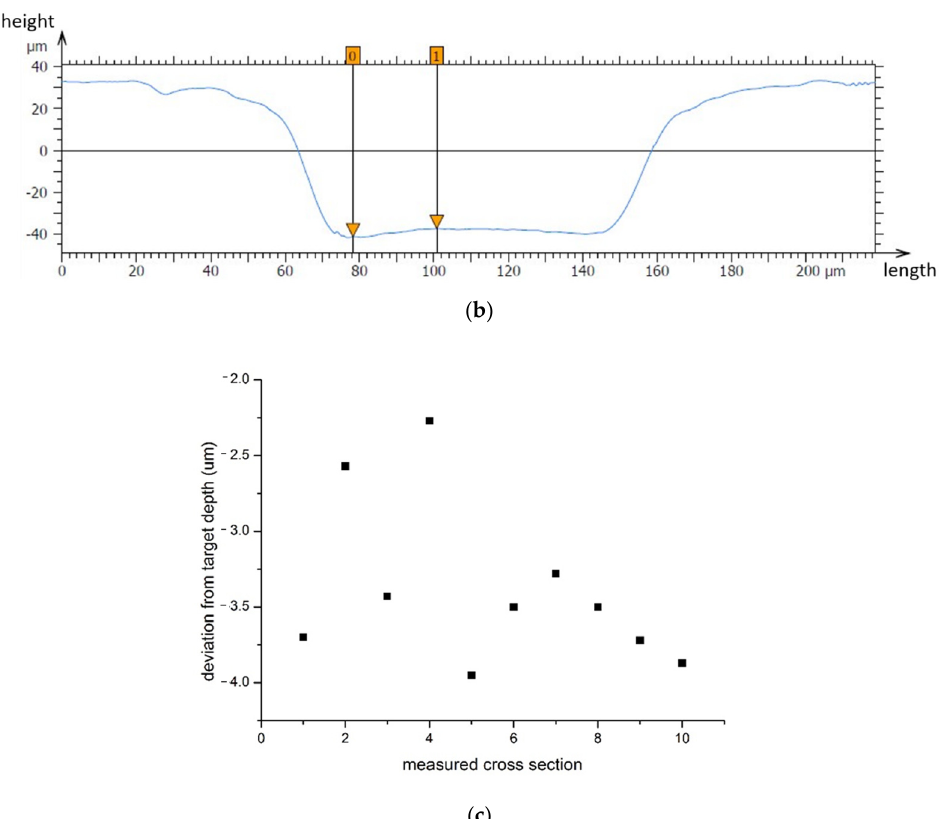
Figure 9. Ten different section positions were selected randomly for depth measurement: ( a ) measurement position of the microgroove cross section, ( b ) bottom morphology of the microgroove and the depth difference between the highest point and the lowest point, and ( c ) deviation from the target depth.